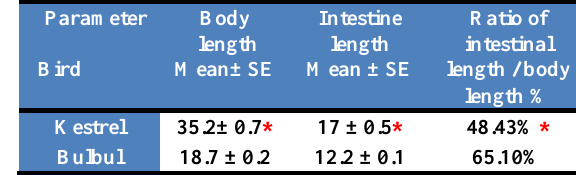
Table, 1: the body length (cm), small intestine length (cm) and the ratio of (IL/BL) in kestrel and